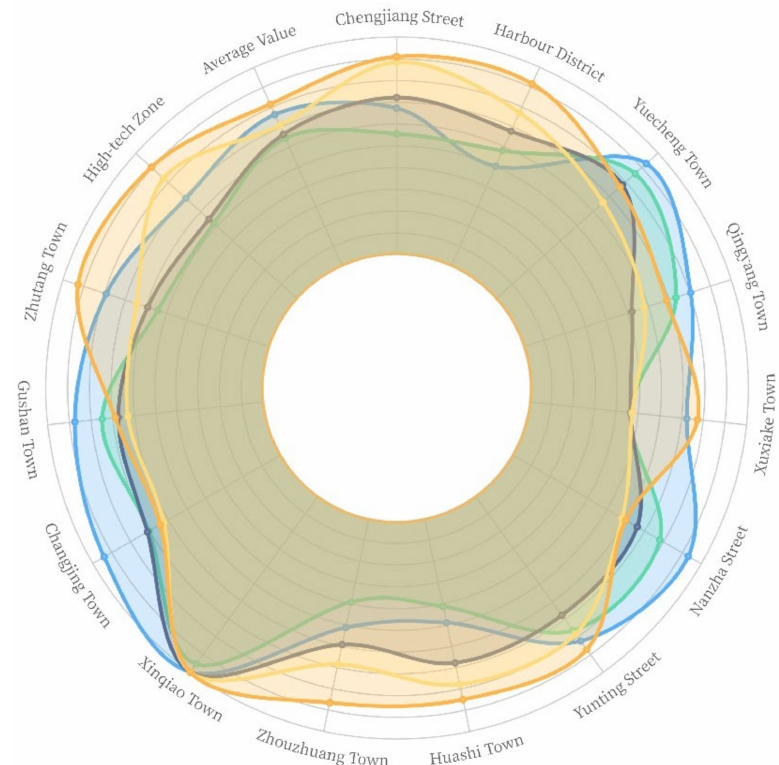
Figure 2. Development performance index of small towns in Jiangyin.